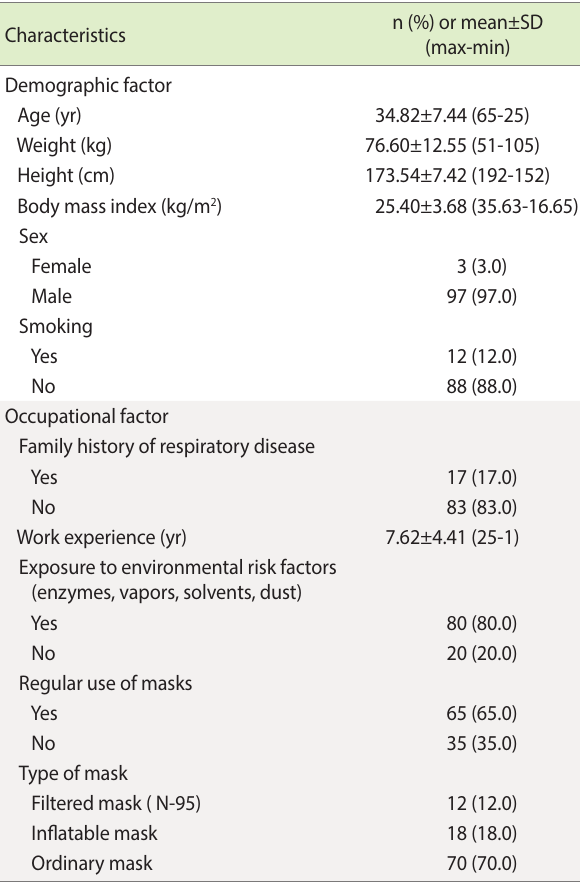
Table 1. Demographic and occupational characteristics of the work- ers in this study